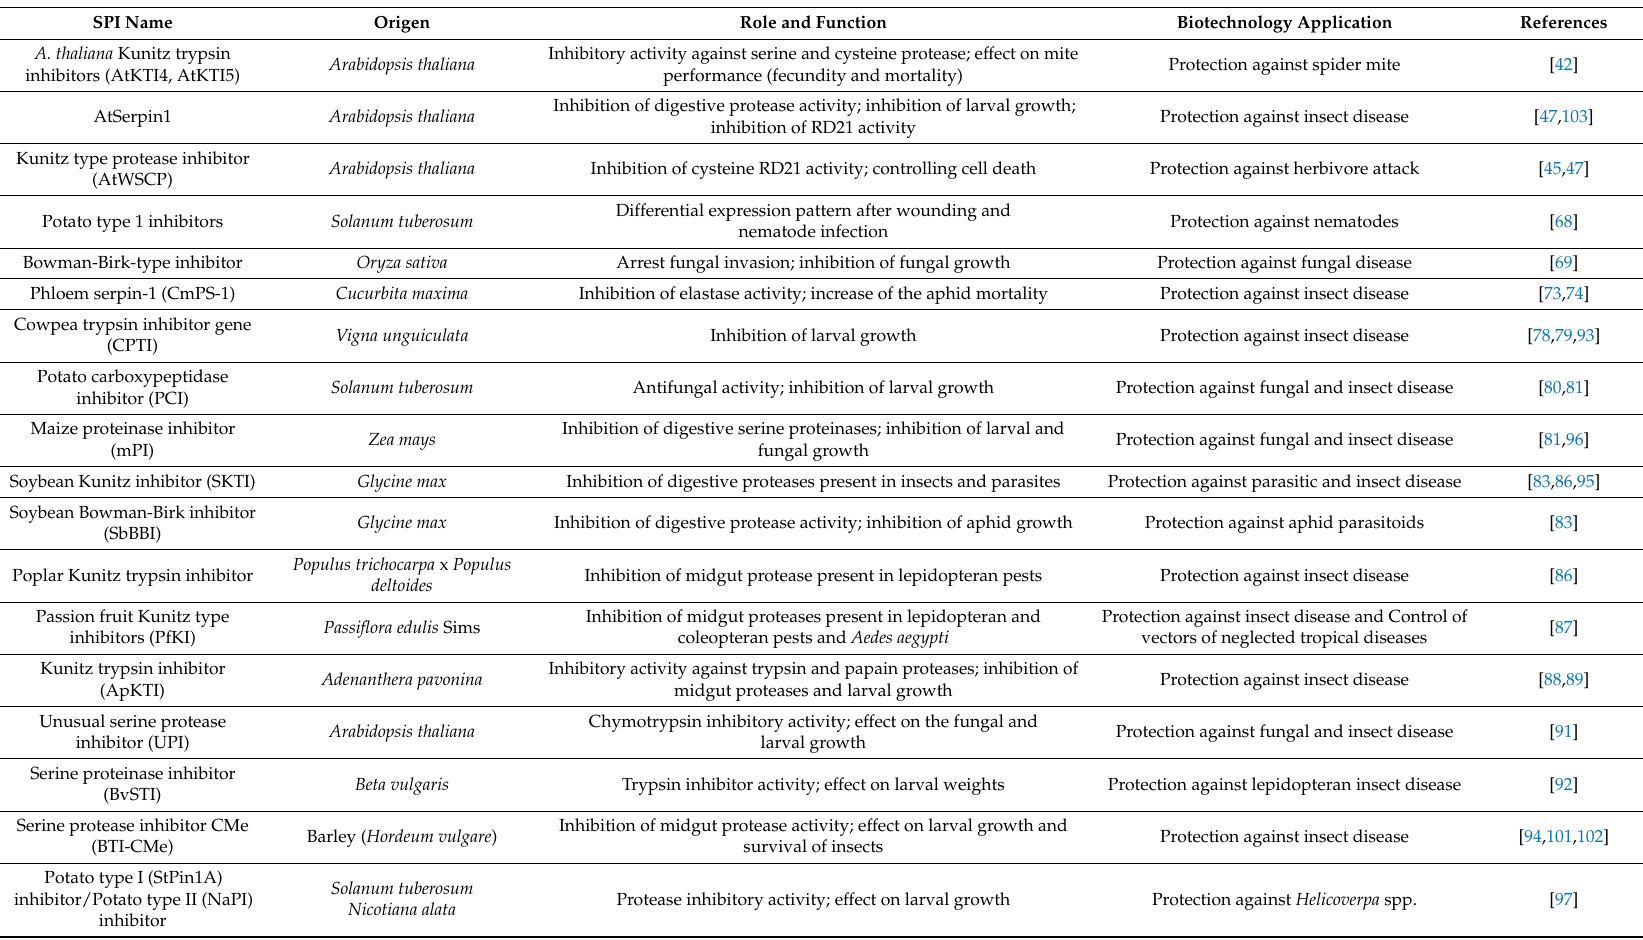
Table 1. Plant protease inhibitors with potential application in agriculture and molecular